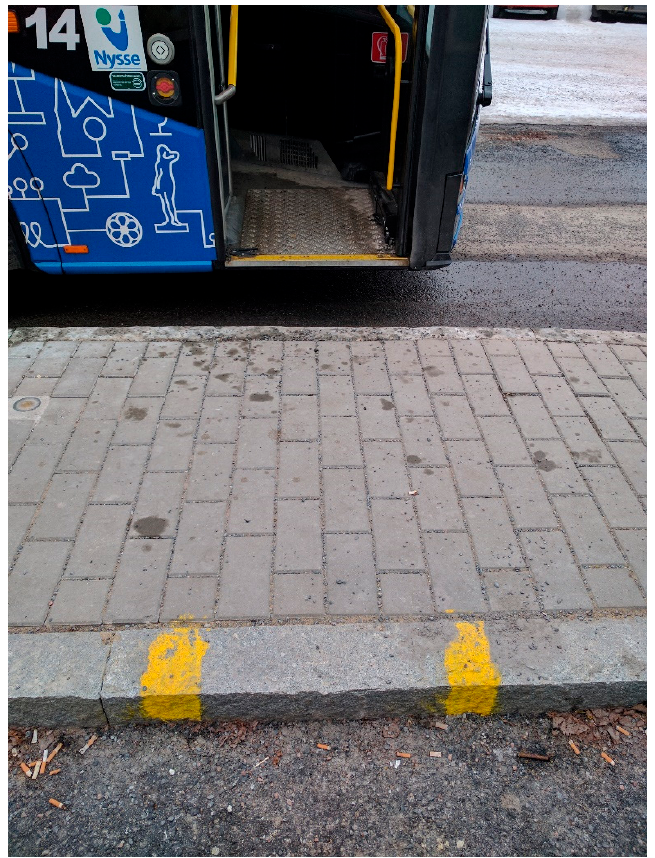
Figure 13. Paint markers on the kerb to position the bus for charging.